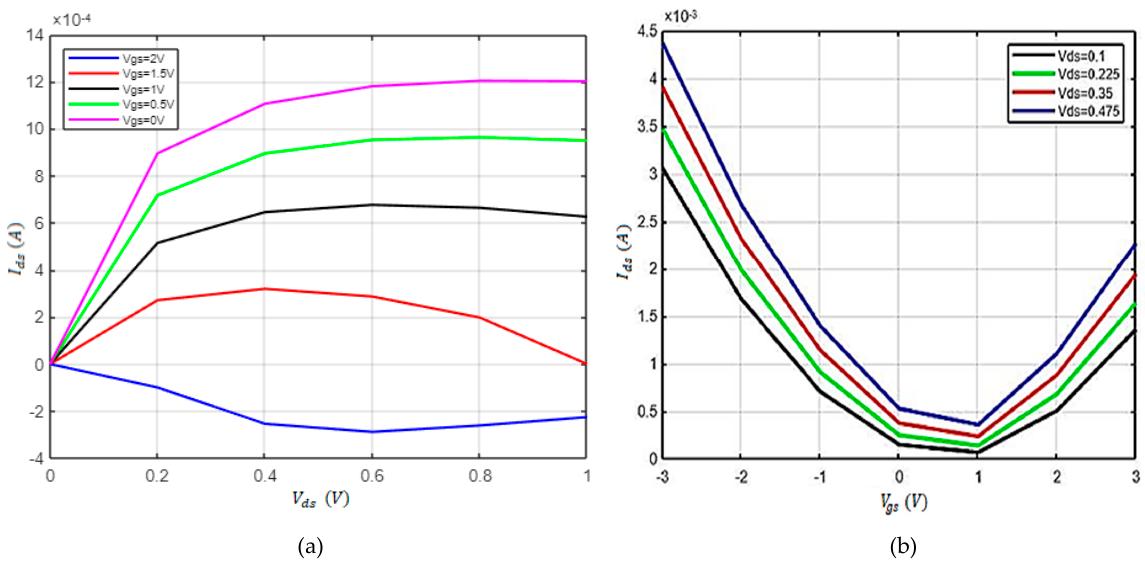
Figure 5. Graphical representation of drain-to-source and gate-to-source voltages with drain current as: (a) output characteristics of GFET and (b) drain current versus top-gate voltage.